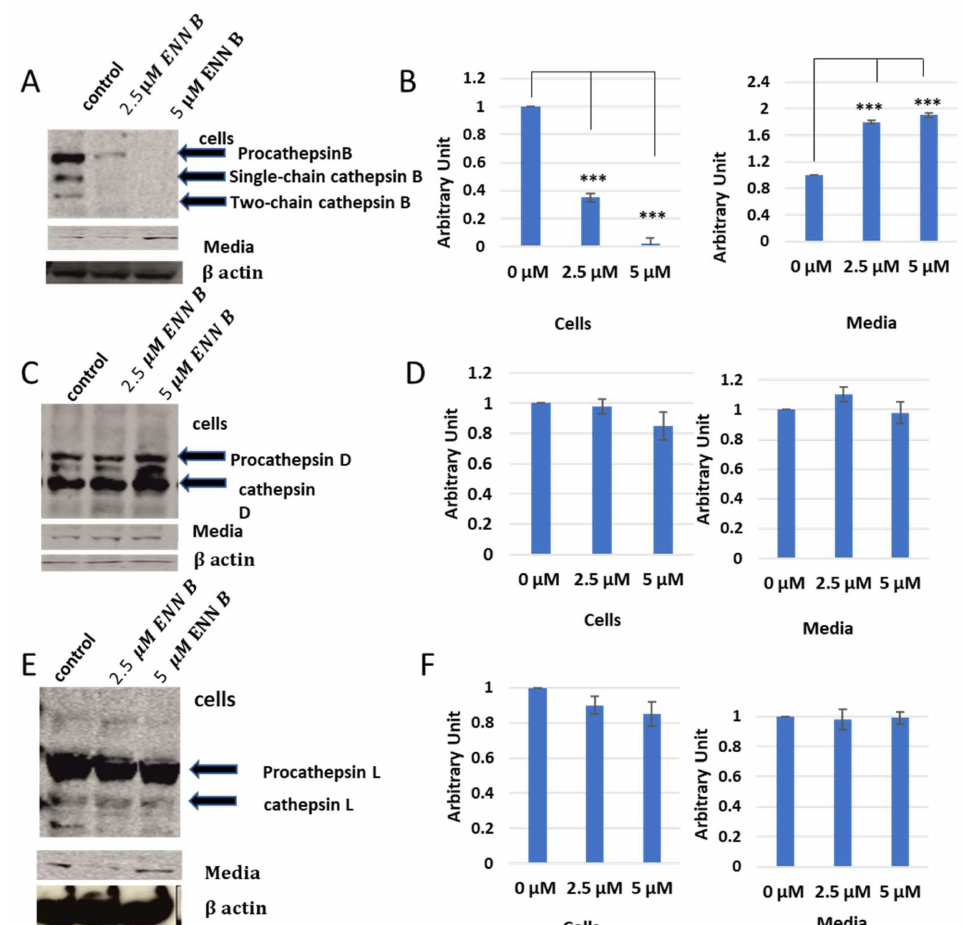
Figure 7. Secretion levels of cathepsin B, cathepsin D and cathepsin L after treatment with different concentrations of ENN B. ( A ) Western blot analysis of cathepsin D in cells and media. ( B ) Evaluation of cathepsin B contents in cells and media. ( C ) Cellular and media contents of cathepsin D. ( D ) Evalu- ation of cathepsin D in cells and media. ( E ) Cellular and media contents of cathepsin L. ( F ) Evaluation of cathepsin L contents in cells and media. The data were analyzed using one way ANOVA with Bonferroni’s and Dunnett’s post hoc analysis (*** p < 0.001; N = 7). Statistics were calculated using GraphPad